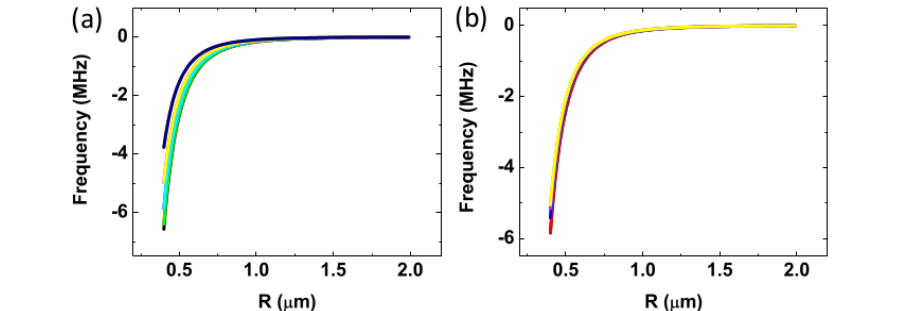
Figure 7. ( a ) the trapping transition shift due to ions; ( b ) the repump transition shift due to